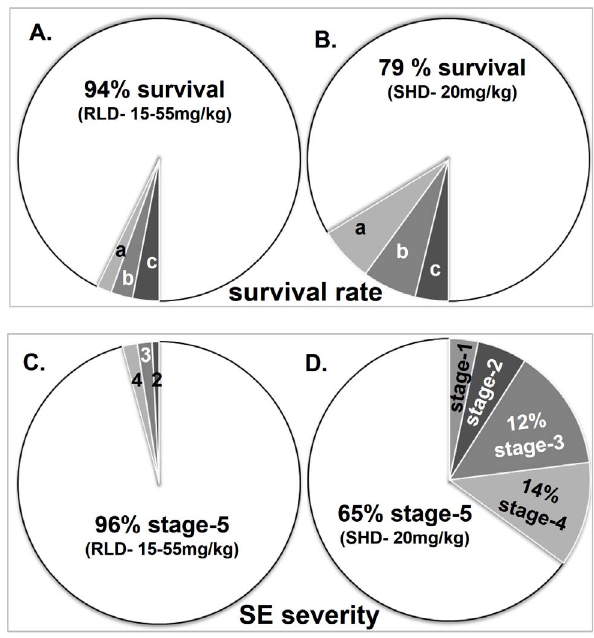
Figure 2. The effects of RLD and SHD of KA on mortality rate and severity of behavioral SE. RLD of KA ranging from 15–55 mg/ kg (3–11 doses of 5 mg/kg at 30 min intervals, i.p.,) reduced mortality rate (A, B) and increased the percentage of animals that reached stage-5 seizures. The RLD method reduced inter-animal variability during different stages of SE (C, D). The lower case letters in pie charts A and B indicate mortality (a) during the SE, (b) soon after diazepam or (c) soon after KA injection ( , 10 min). The numbers in pie charts C and D indicate the stages of the seizures. N=82 for RLD group; five mice died during SE after reaching stage-5 seizures, three mice did not reach stage-5 seizure, all mice except one reached stage-3 seizures; N=24 for SHD group, five mice died during SE after reaching stage-5 seizures, eight mice did not reach stage-5, and 2 mice did not reach stage-3. p=0.029 for mortality and p=0.001 for